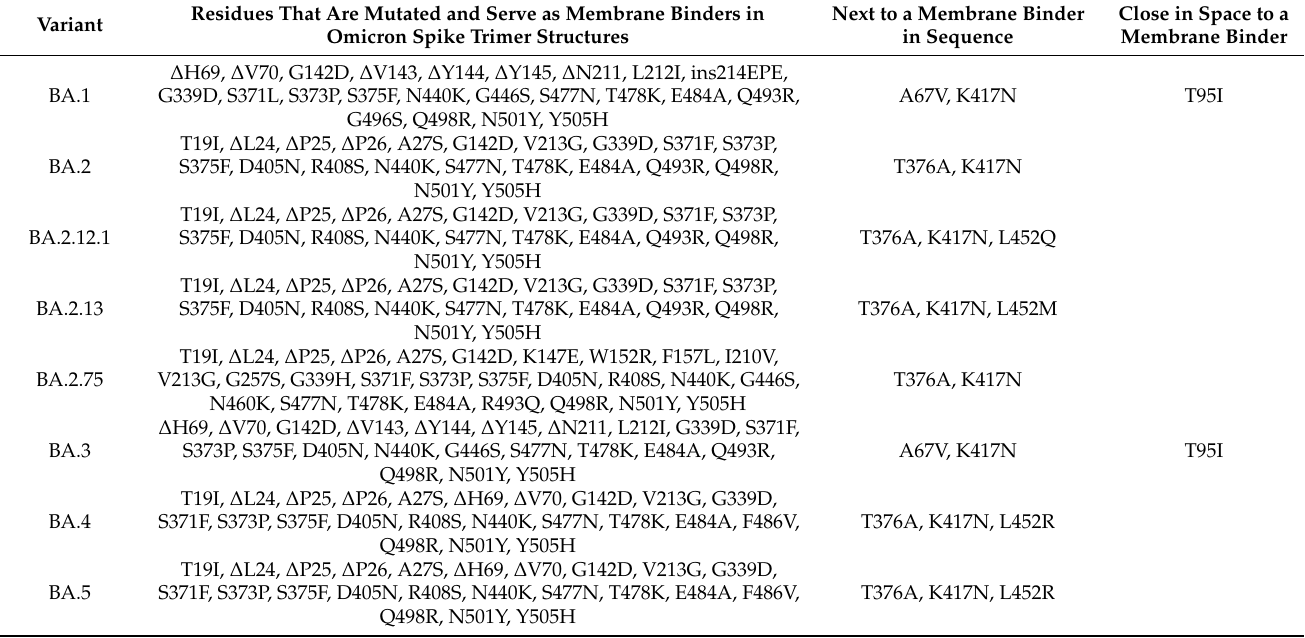
Table 1. Mutations in the NTD and RBD modules of SARS-CoV-2 variant spikes emerging in 2022. Of these mutations, most are in positions predicted by MODA to bind membranes directly in multiple Omicron spike trimer structures, others are sequentially beside motifs predicted to bind membranes, and the remainder are spatially adjacent to residues that are predicted to bind